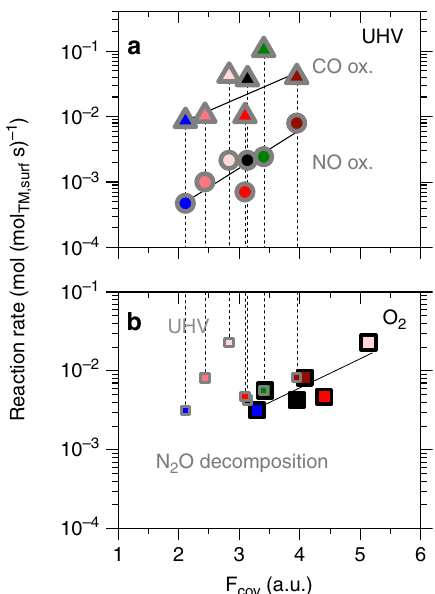
Fig. 5 Correlation of catalytic rates with covalency. Dependence of reaction rates on covalency, F cov , at 623K: a NO oxidation (523K) and CO oxidation rates (443K) with F cov as determined in ultrahigh vacuum (UHV) b N 2 O decomposition rates (673K) as function of F cov in O 2 presence (large squares) and UHV (small squares). Symbol edge color identi fi es F cov in O 2 presence (black) or ultrahigh vacuum (gray). Fill colors represent the substituent cation in LaCoO 3 (no substituent: black fi ll): Ni (green), Zn (blue), increasing Al fraction (dark to light red). Solid lines represent least squares fi